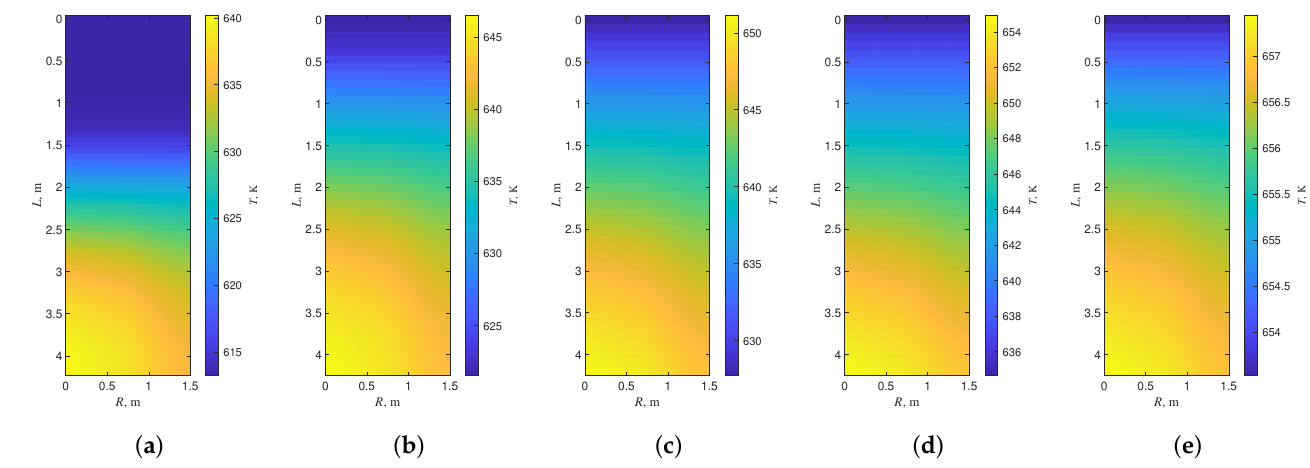
Figure 3. The temperature distribution of each stage of the reactor. ( a ) Temperature distribution of the first stage, ( b ) Temperature distribution of the second stage, ( c ) Temperature distribution of the third stage, ( d ) Temperature distribution of the fourth stage, ( e ) Temperature distribution of the fifth stage.